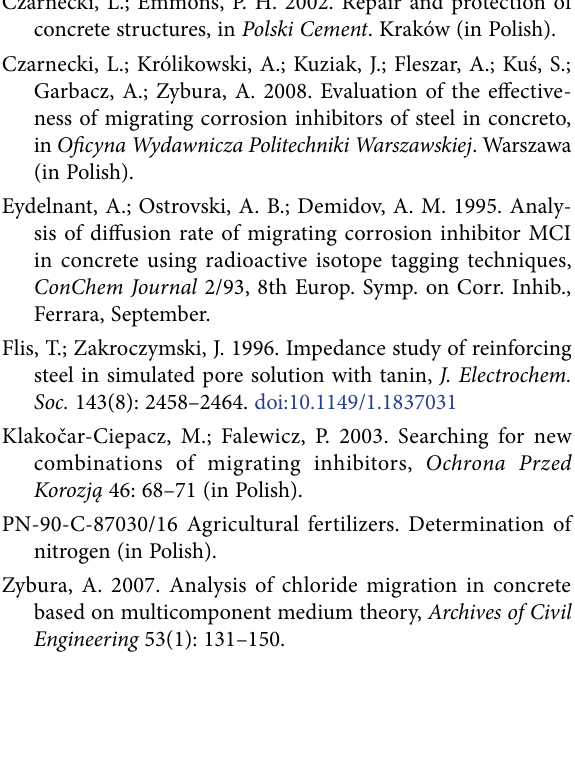
The curve of graph indicates that the diffusion coefficient of compound DME reached a stable value D = 2.776 × 10 –7 cm 2 /s at a difference of average DME